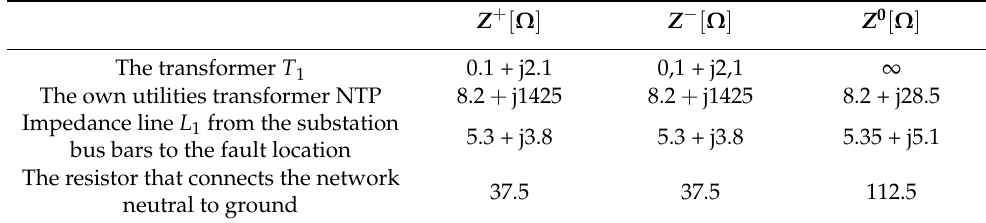
Table 1. Sequence parameters of the elements in Figure 1.